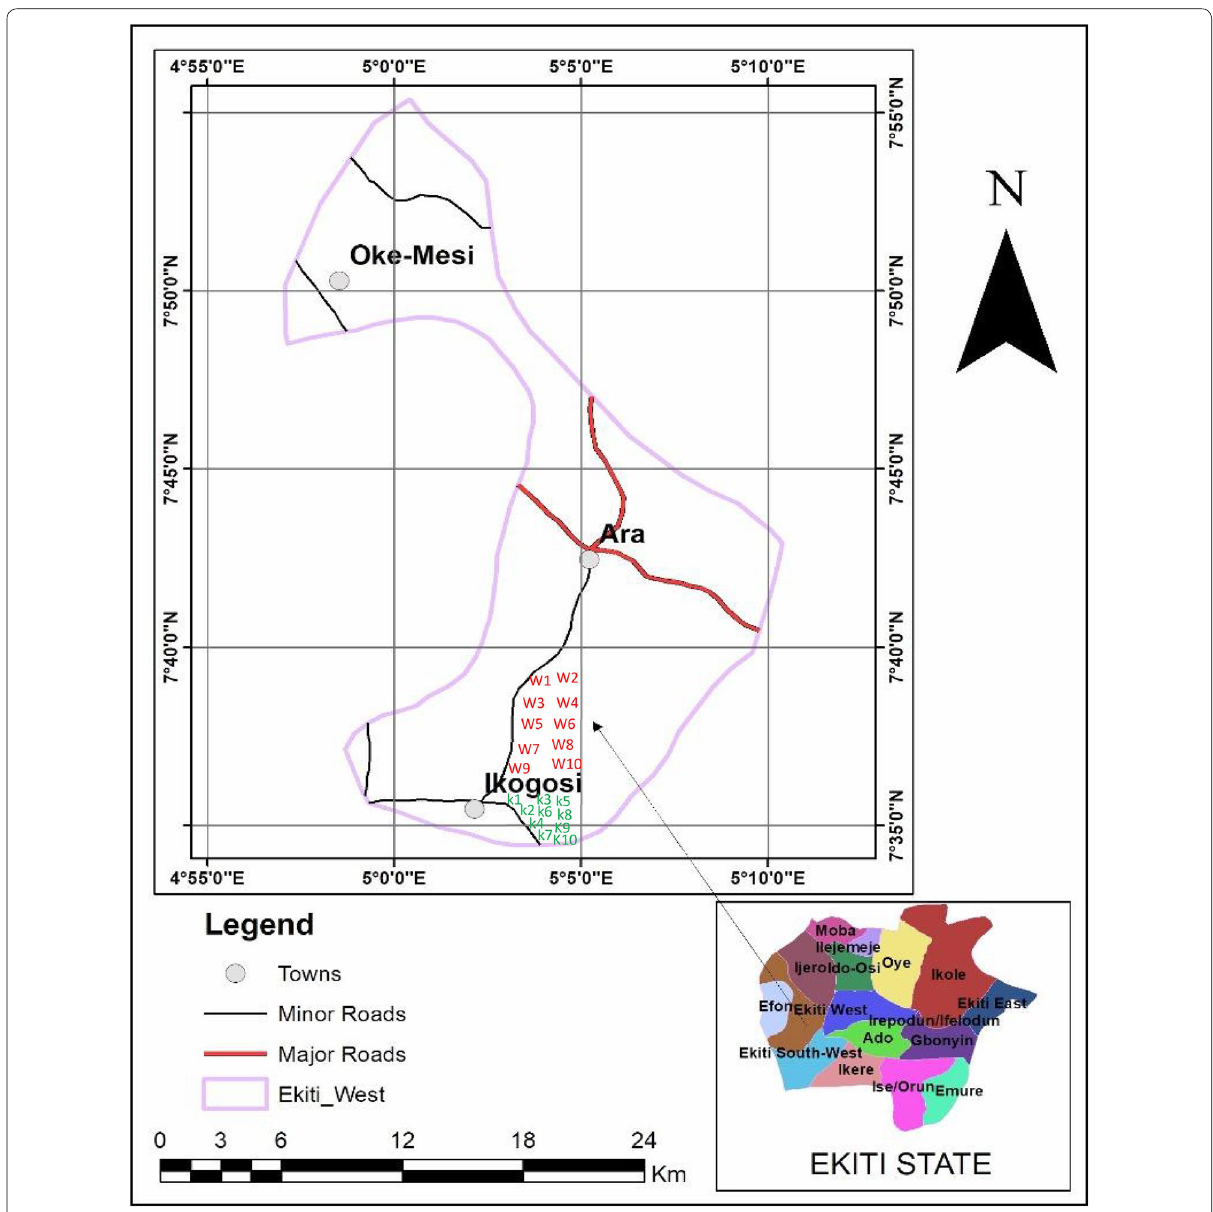
Fig. 1 Schematic map of the study